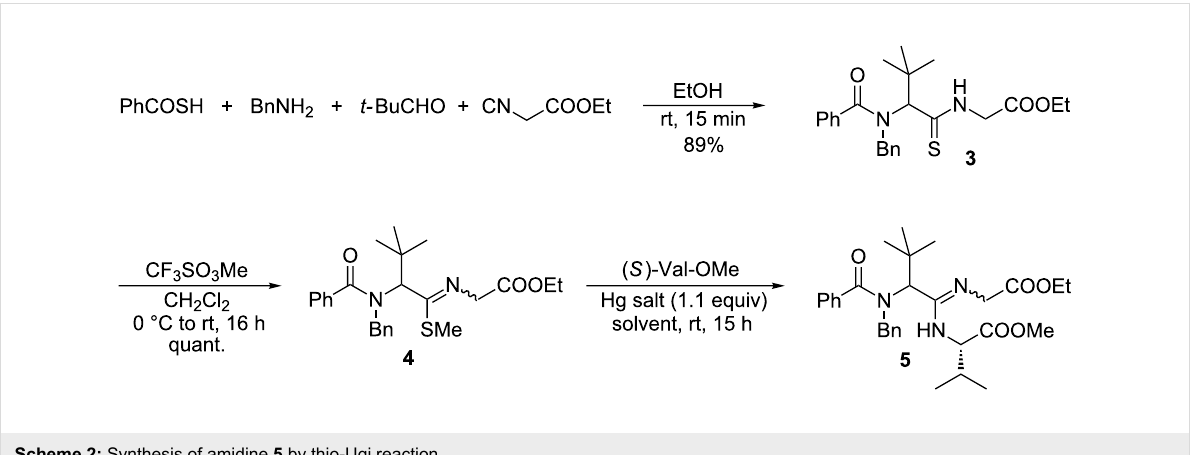
Scheme 2: Synthesis of amidine 5 by thio-Ugi reaction.